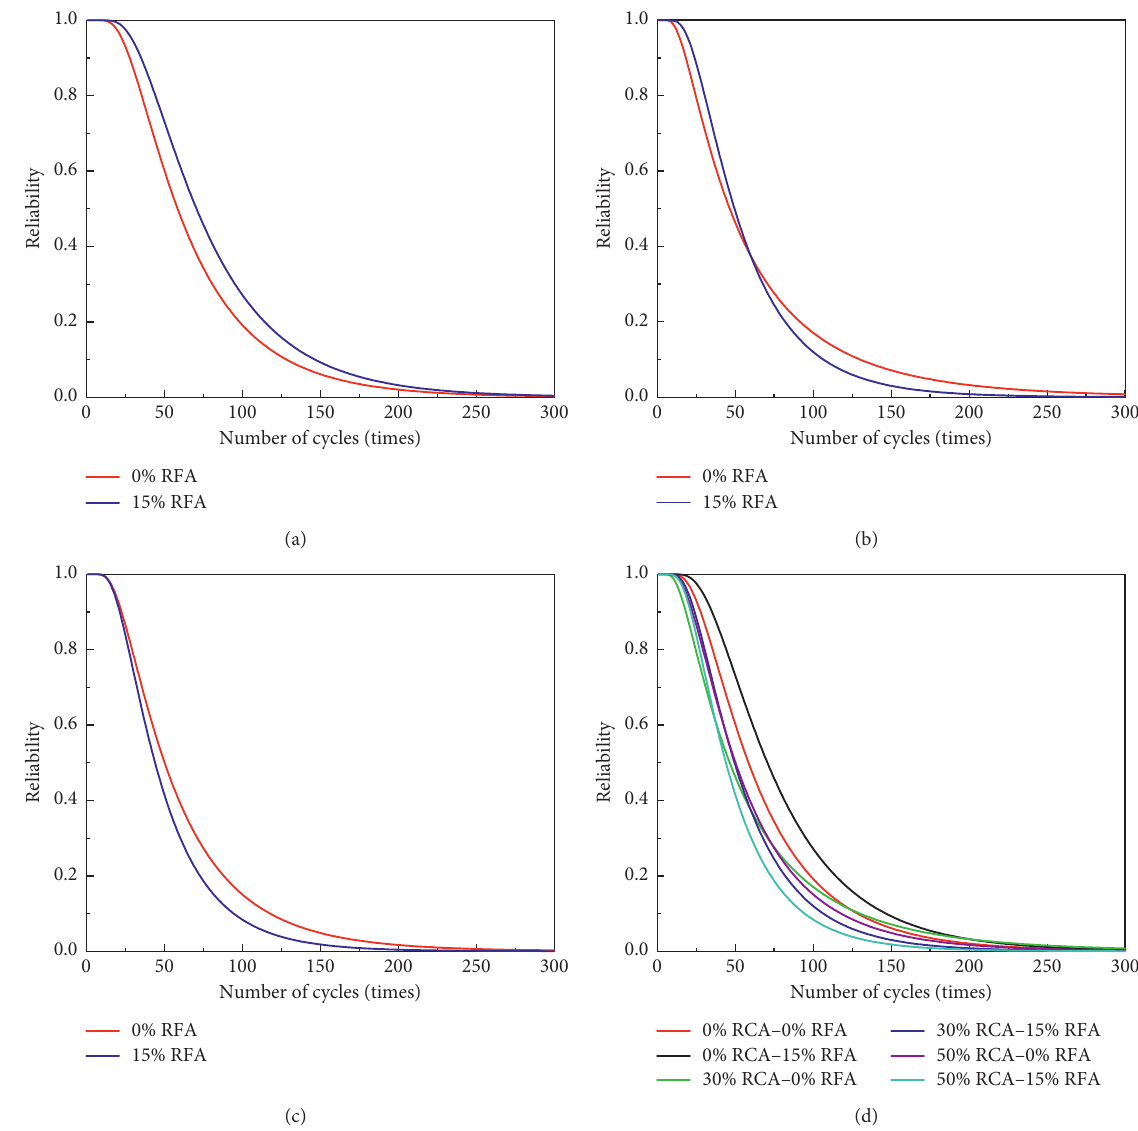
Figure 8: Reliability curve of sulfate resistance of concrete with different mix ratios. (a) RCA0%. (b) RCA30%. (c) RCA50%. (d)